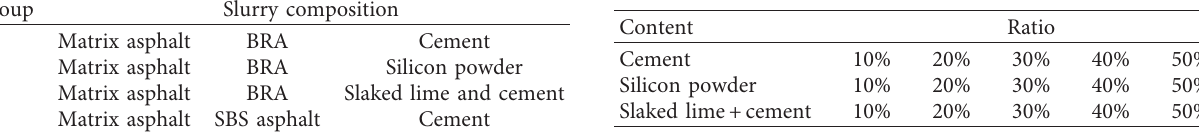
Table 8: Test scheme of